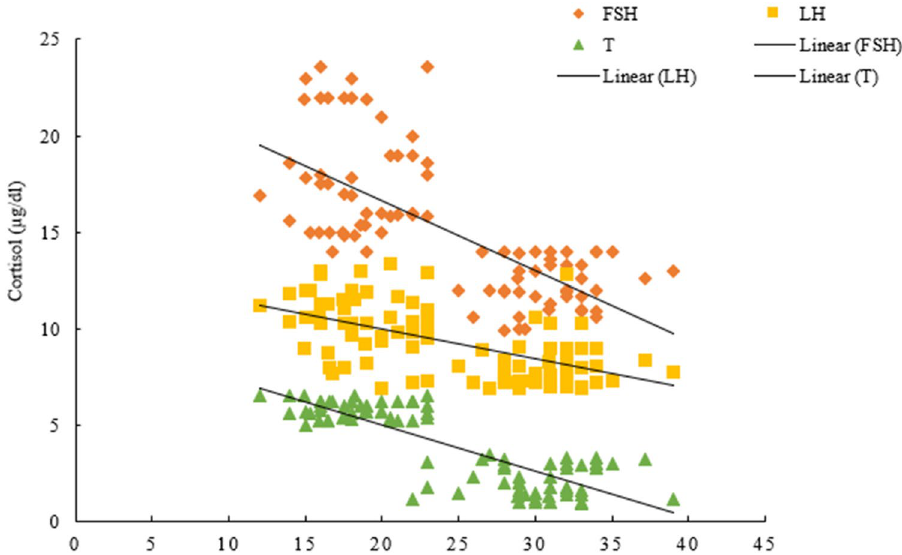
Figure 3. Plasma LH, FSH and testosterone concentration as a function of cortisol at brick kiln sites in adult male workers.